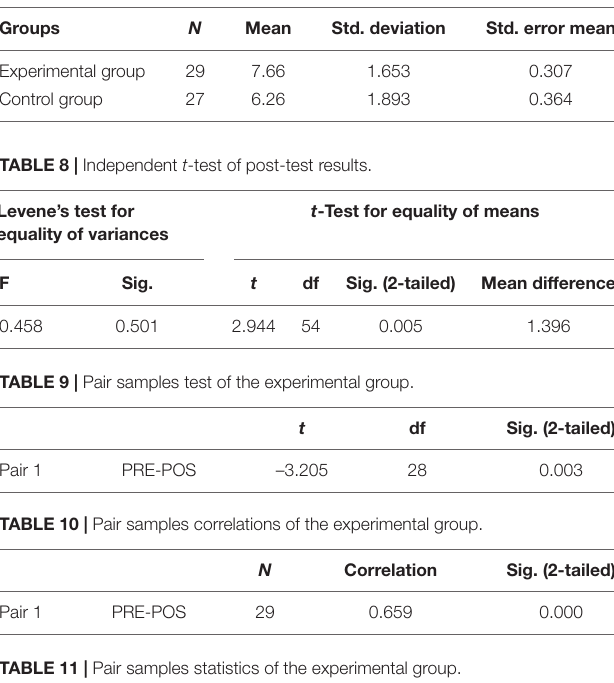
TABLE 7 | Descriptive statistics of post-test scores.